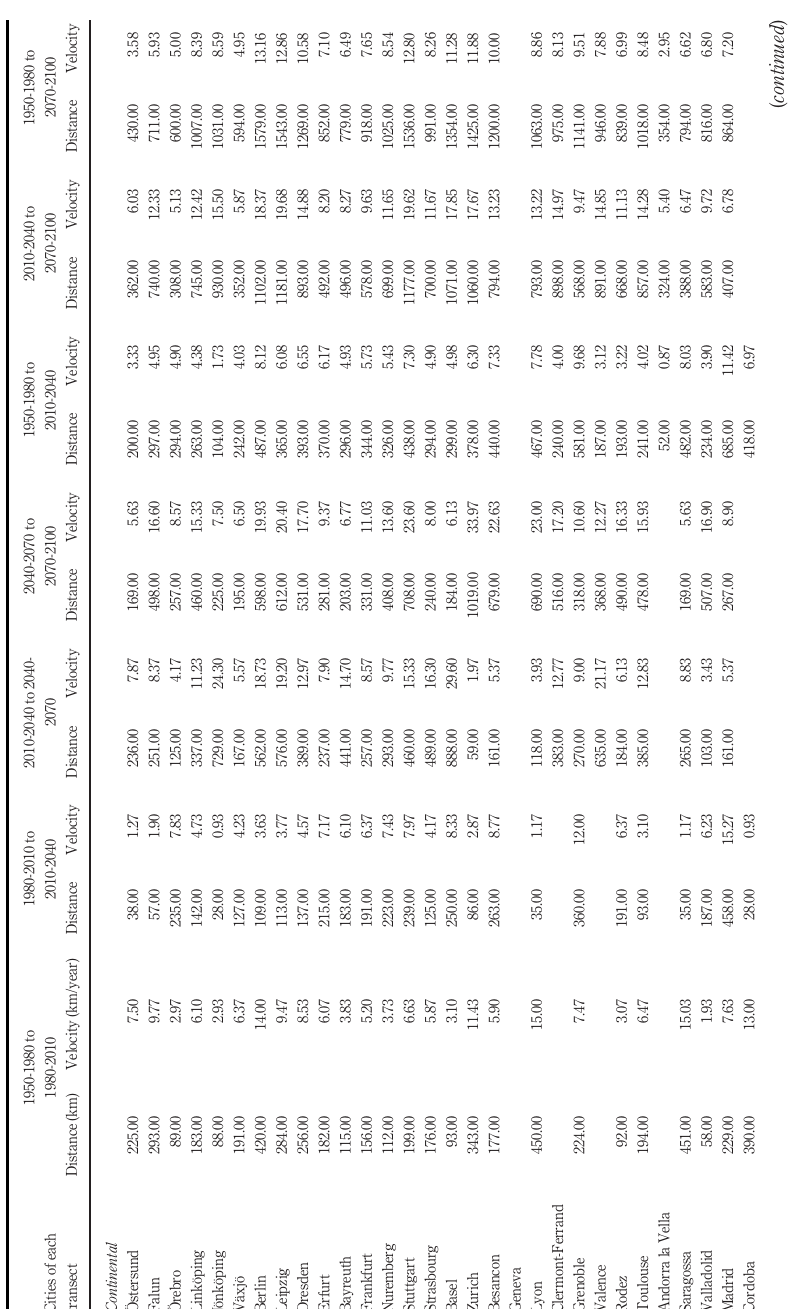
Table AII. Full results of the southward velocity computations for the 90 investigated cities and the seven shift time